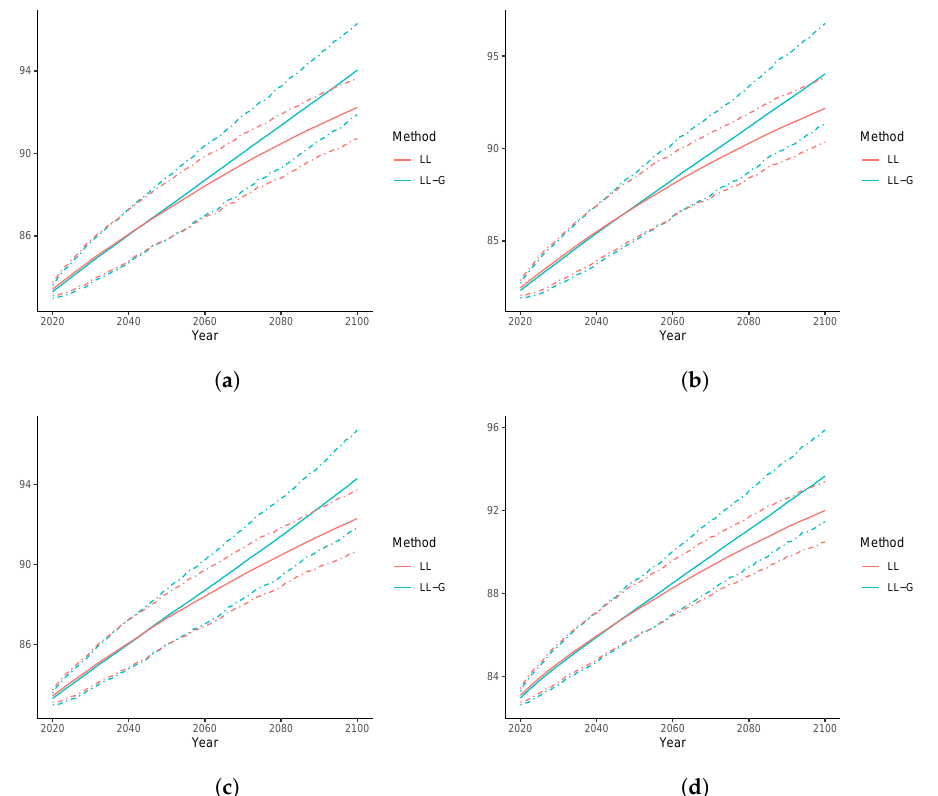
Figure 9. Forecast e 0 over 2020–2100, Multi-population models: ( a ) Australia; ( b ) Canada; ( c ) Spain; ( d )